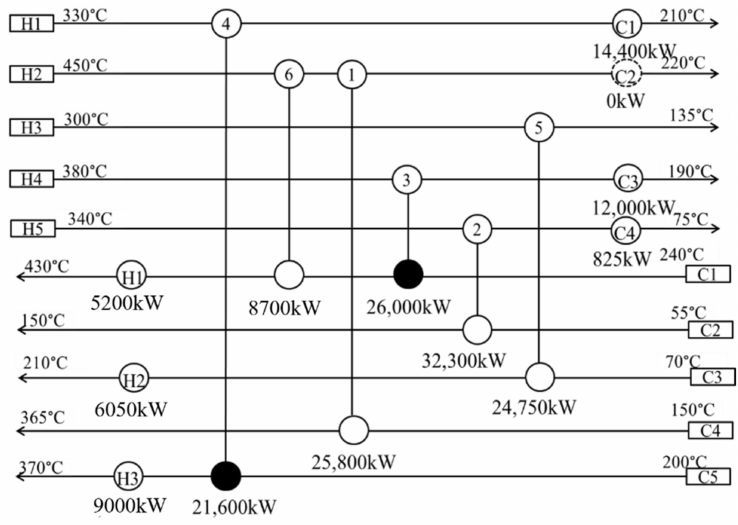
Figure 20. The pinched HEN for case study 3.